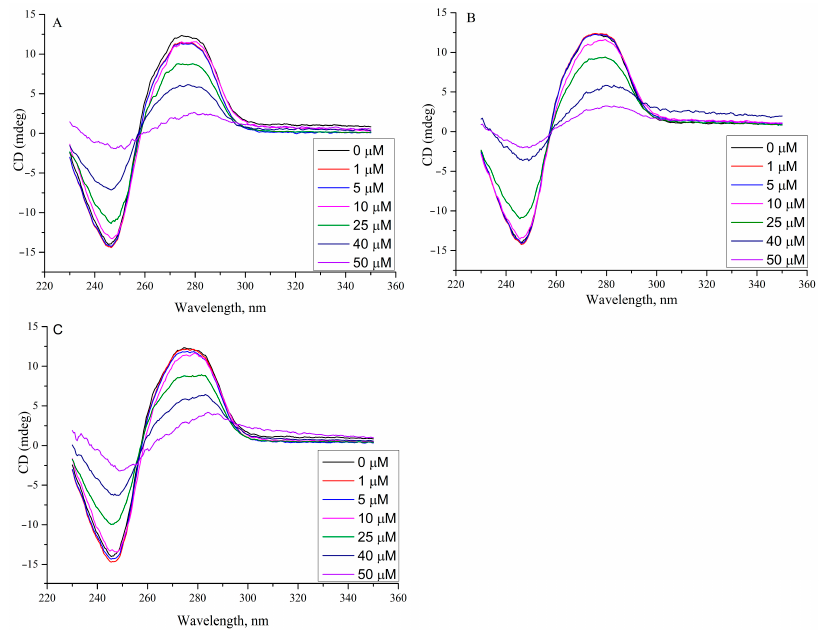
Figure 5. Circular dichroism (CD) spectra of CT-DNA (50µM) in the absence a and presence of different amounts of the macrocycles ( A )— 5 , ( B )— 6 , ( C )— 7 . Upon the addition of the macrocycle to the CT-DNA solution, the intensity of both positive and negative CD bands decreases and shifts to the red region to 286 and 250 nm, respectively. The observed redshift with a decrease in intensity during complexation can be attributed to a structural transition from the B- to C form, accompanied by the DNA compaction process, which was previously shown for cationic surfactants [60,61]. 2.3.4. Particle Size and Zeta Potential Measurements The above spectroscopic studies, including UV, fluorescence and CD, showed that macrocycles 5 – 7 can effectively interact with CT DNA. Previously, it was shown that am- phiphilic macrocycles with diethylenetriamine groups are capable of compacting CT DNA into small globules [29,30]. The particle size and zeta potential of the CT DNA-mac- rocycle complexes with different concentrations were studied by the DLS method (Figure 6).